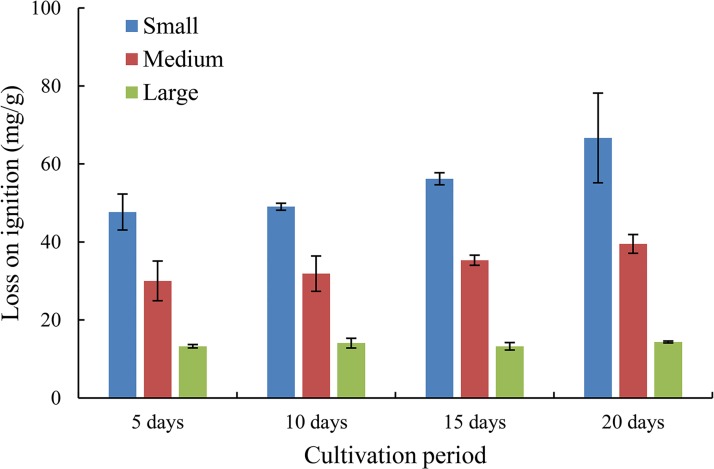
Relations between loss on ignition (LOI) and cultivation period for three groups of size-fractionated sediment: small (0–0.02 mm), medium (0.02–0.05 mm) and large (0.05–0.10 mm).